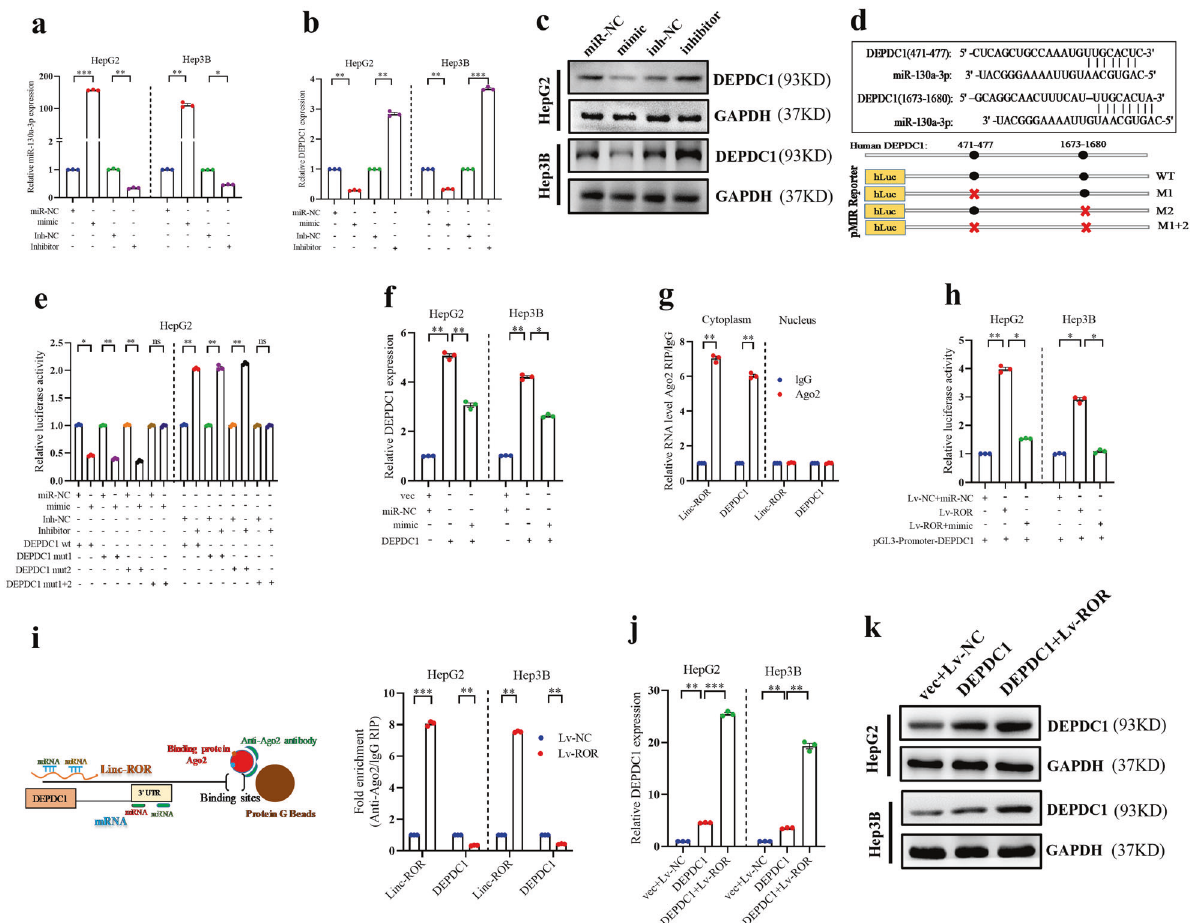
Fig. 3 Linc-ROR act as ceRNAs. a The qRT-PCR assay revealed the overexpression and knockdown ef fi ciency of miR-130a-3p in HepG2 and Hep3B cells. b , c The mRNA and protein levels of DEPDC1 in HepG2 and Hep3B cells after transfection with miR-130a-3p mimic or miR-130a-3p inhibitor. d The miR-130a-3p binding sequence in the DEPDC1 3 ʹ UTR and the generation of dual-luciferase reporter plasmids of wild-type (WT) or mutant (MUT) were shown. e Luciferase activity assays were performed in HepG2 cells co-transfected with DEPDC1 WT or DEPDC1 MUT and miR-130a-3p mimic or miR-130a-3p inhibitor. f The relative expressions of DEPDC1 were determined transfected with miR-130a-3p mimic or DEPDC1 by qRT-PCR. g RIP experiments revealed that Linc-ROR and DEPDC1 mRNA coexisted in the anti-Ago2 complex in the cell cytoplasm. IgG was used as the negative control. h Luciferase activity in HCC cells co-transfected with pGL3-promoter-DEPDC1 and ceRNAs. Data were presented as the relative ratio of renilla luciferase activity and fi re fl y luciferase activity. i The schematic diagram and qRT-PCR results of the RIP based on Ago2 showed that Linc-ROR can compete with the DEPDC1 transcript for the binding of miRNAs. j , k The relative expression levels of DEPDC1 were determined by qRT-PCR and western blotting in HepG2 and Hep3B cells after co-transfecting ceRNAs. Data are shown as mean ± SD, n = 3. The data statistical signi fi cance is assessed by Student ’ s t test. * P < 0.05, ** P < 0.01, *** P <